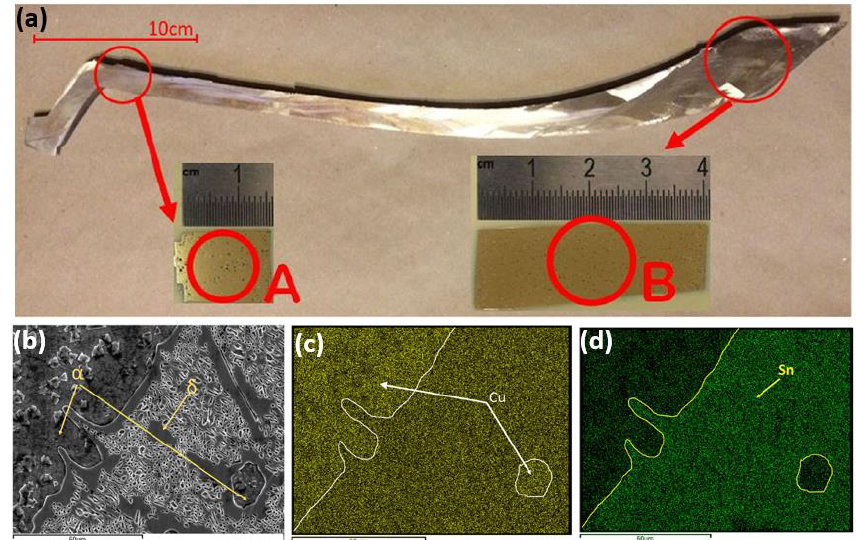
Figure 5. Microstructural analysis of an as-cast bronze bell. ( a ) The cut view areas of the test points A (top) and B (bottom) of the bronze cast bell. ( b – d ) Scanning electron microscopy and the elemental distribution in areas with increased Cu and Sn contents, respectively [77].